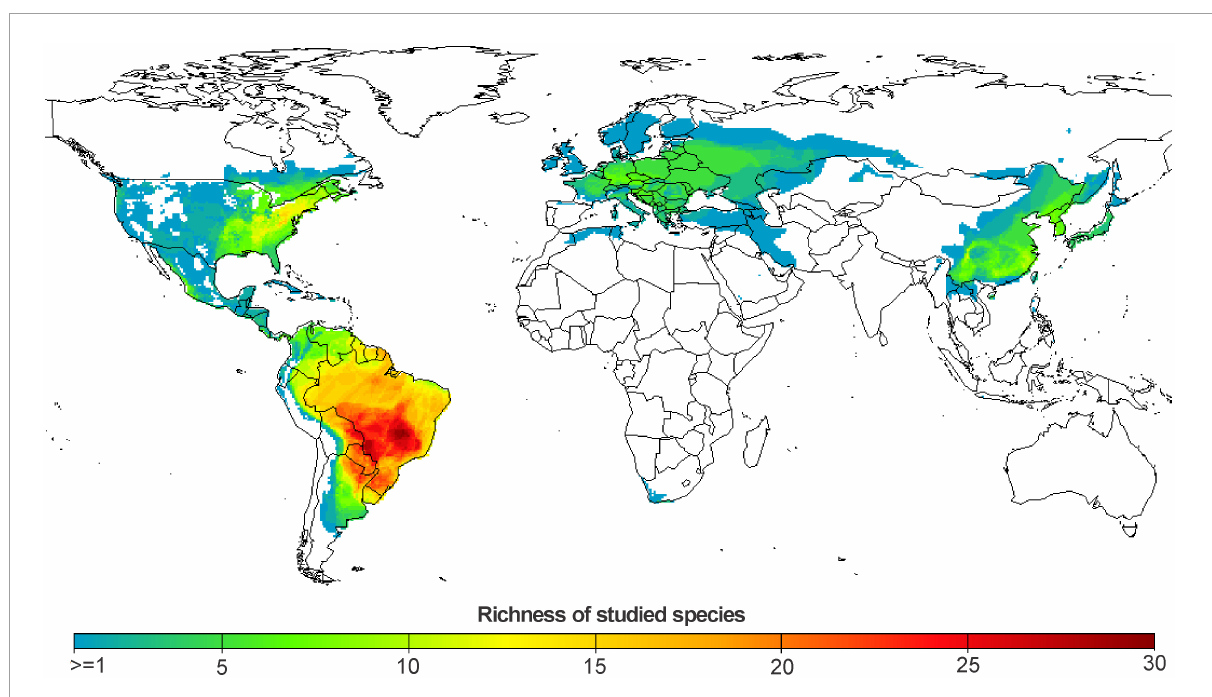
FIGURE2 Richness of amphibian species (331 species) studied in the articles included in our review (31 studies). The blue and green colors represent places where a smaller number of species were studied, while the yellow and red colors represent the places with the largest number of species studied.